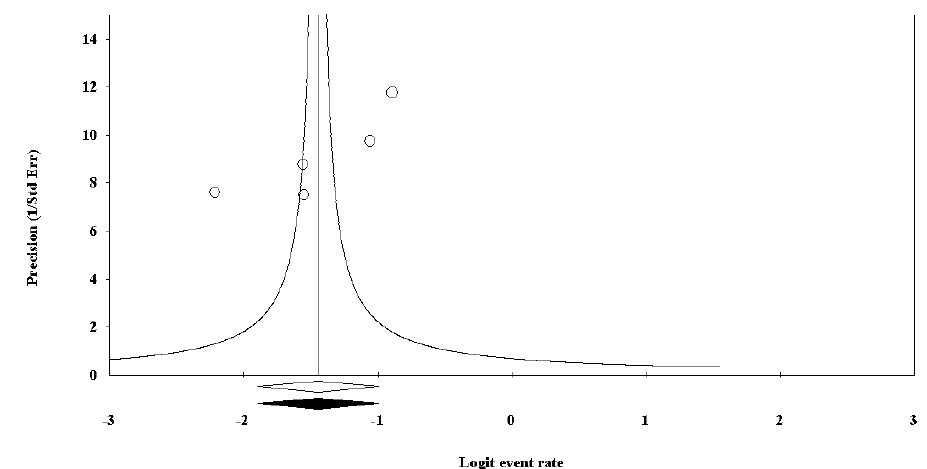
Figure 5. Funnel plot for binge drinking among truck-drivers, showing no evidence of publication bias. Table 6. Duval and Tweedie’s trim-and-fill analysis for binge drinking rate among truck drivers. Random-Effects Model